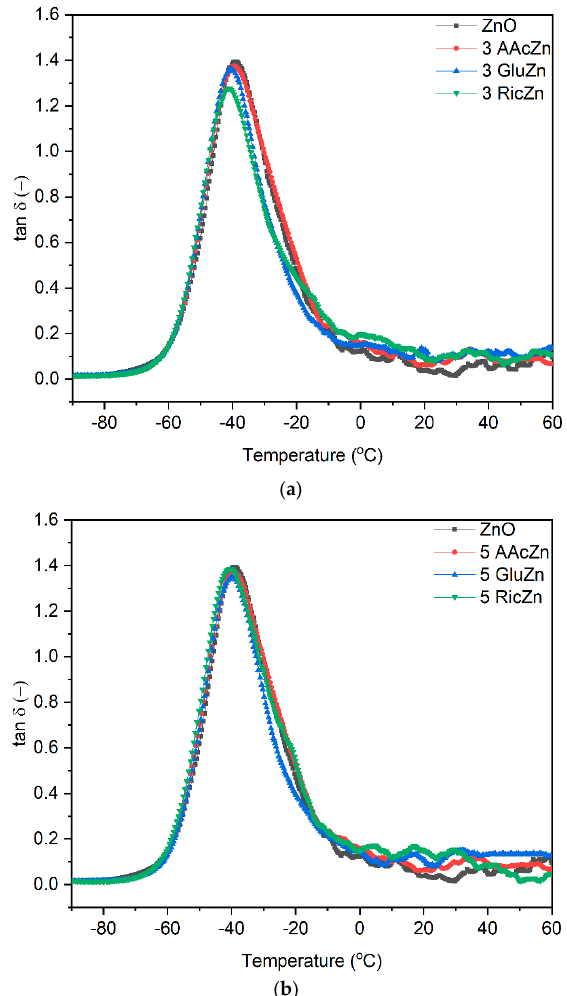
Figure 6. Loss factor (tan δ ) versus temperature of SBR vulcanizates with varying activators: ( a ) 3 phr, ( b ) 5 phr.